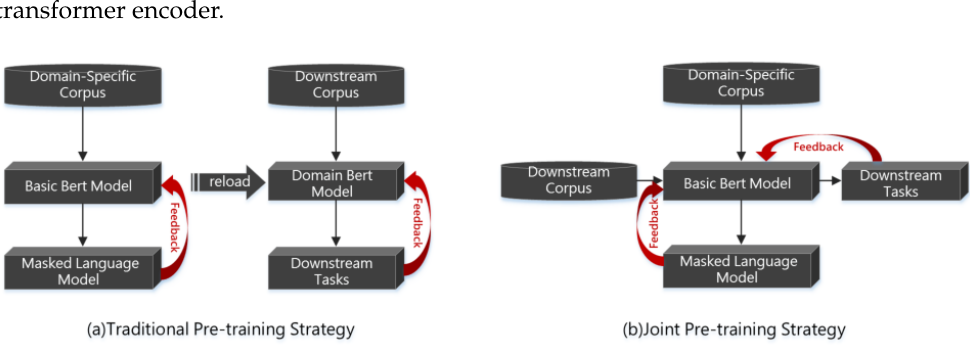
Figure 1. Traditional and Joint Pre-training